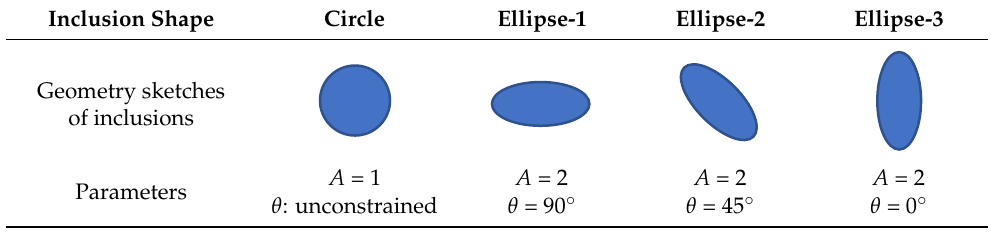
Table 1. Geometry sketches of inclusions with different shapes in this study and the corresponding values of aspect ratio A and the rotation angle θ .